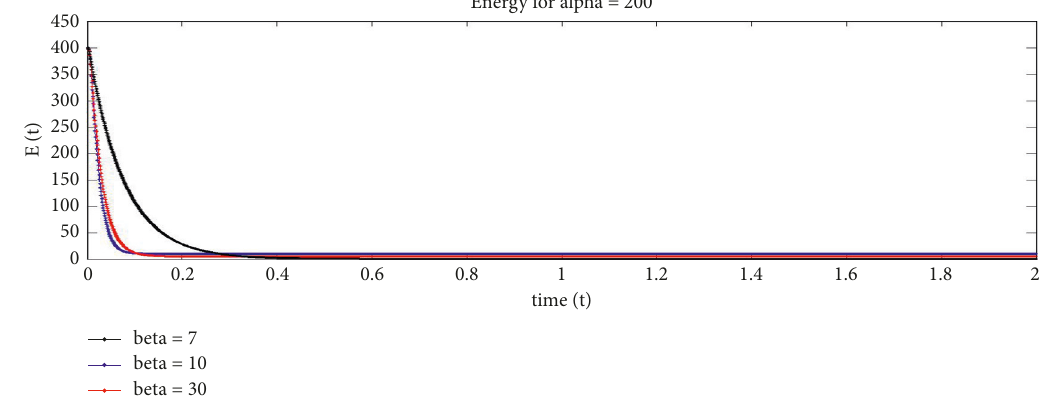
Figure 4: Influence of the parameter β on the energy. Table 1: Vibrations damping times δτ of the beam (in